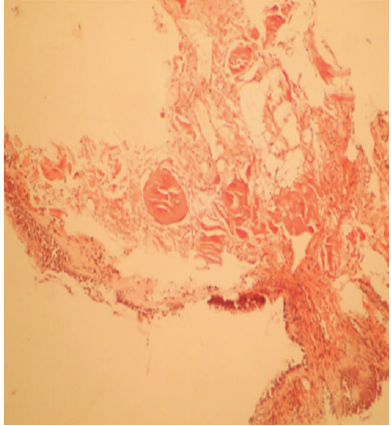
Figure 2: Transbronchial biopsy stained positive with Congo red.